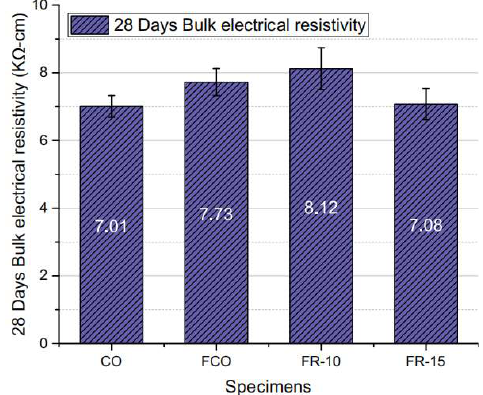
Figure 24. The bulk electrical resistivity of concrete specimens [78].